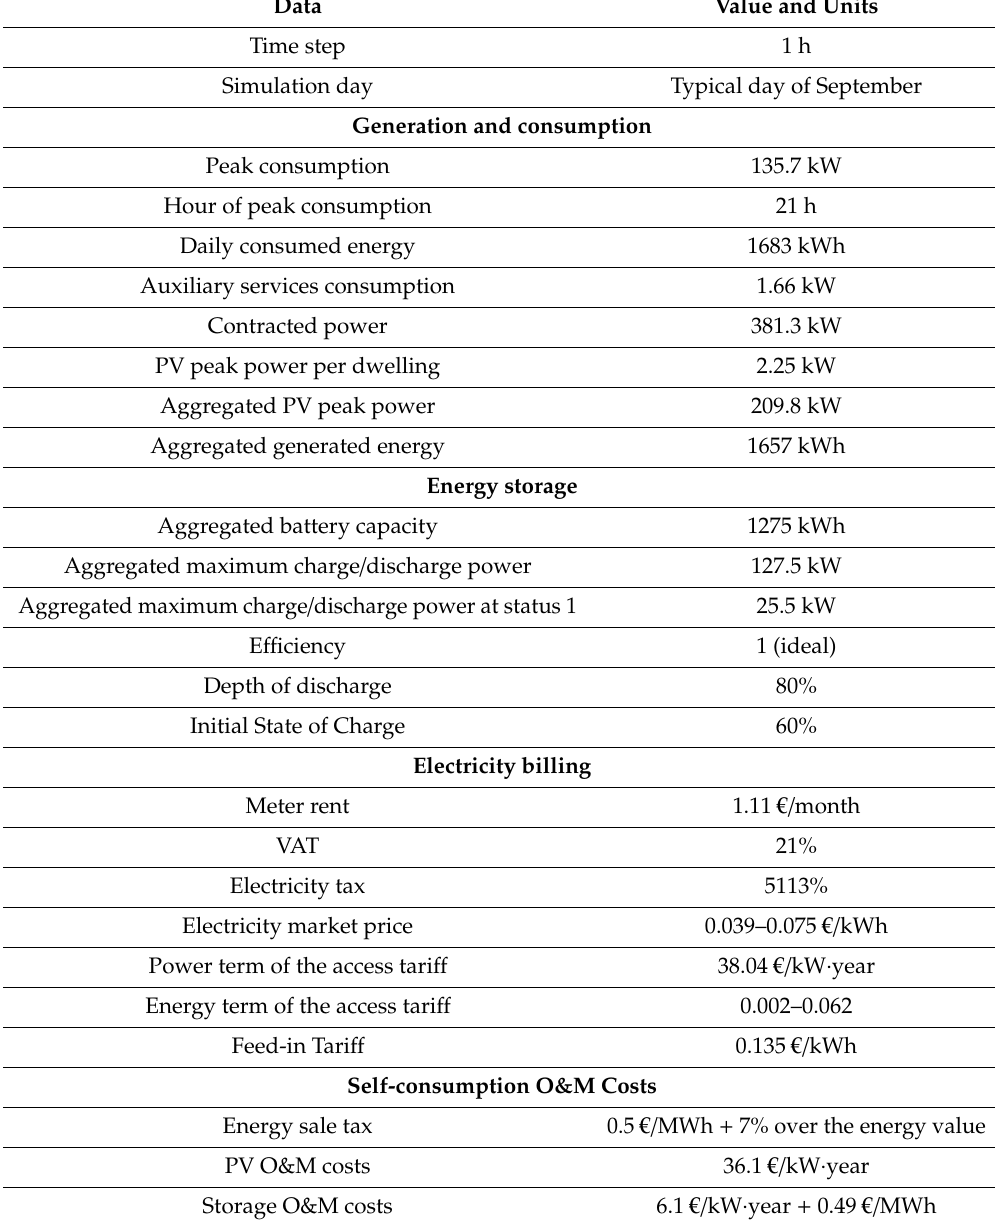
Table 4. Data employed for the energy community